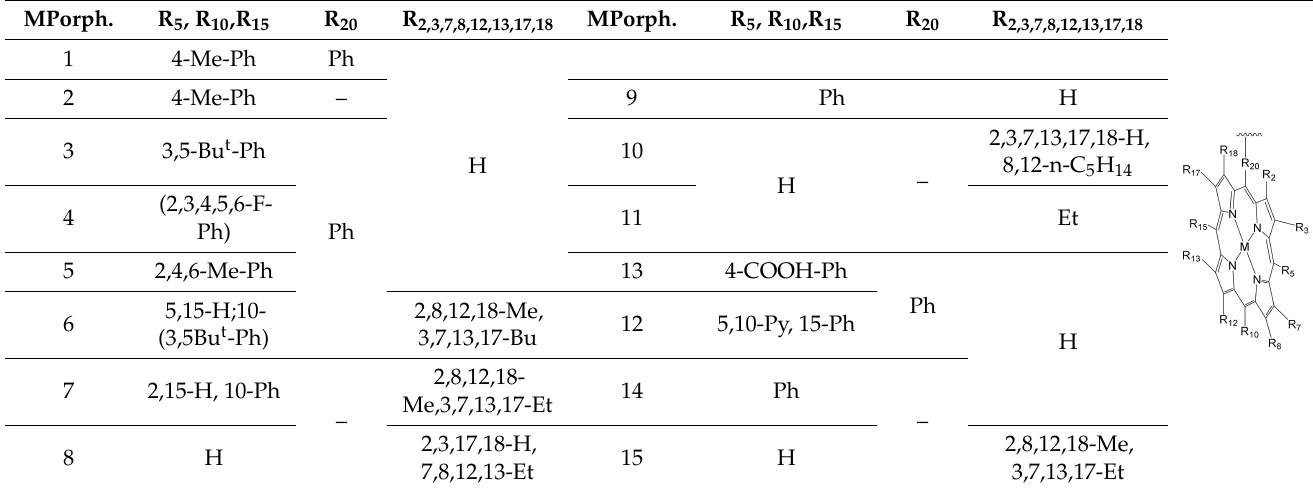
Table 2. Structure of the porphyrin